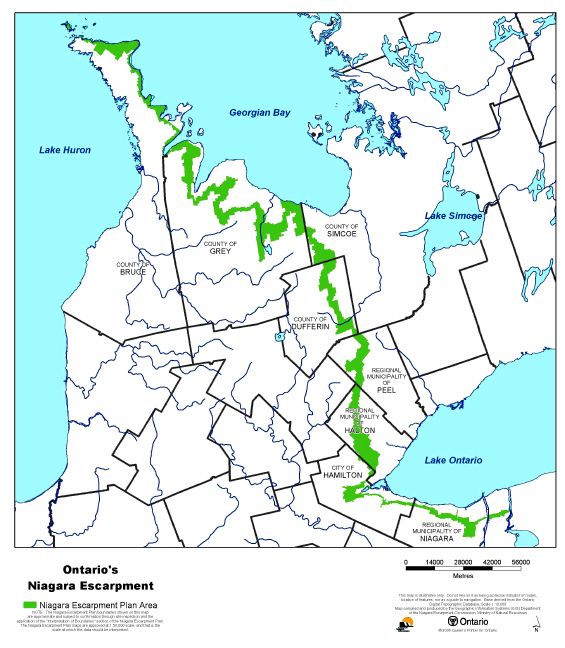
Fig. 3. Niagara Escarpment plan area in Ontario (Source: Niagara Escarpment Commission 2006).